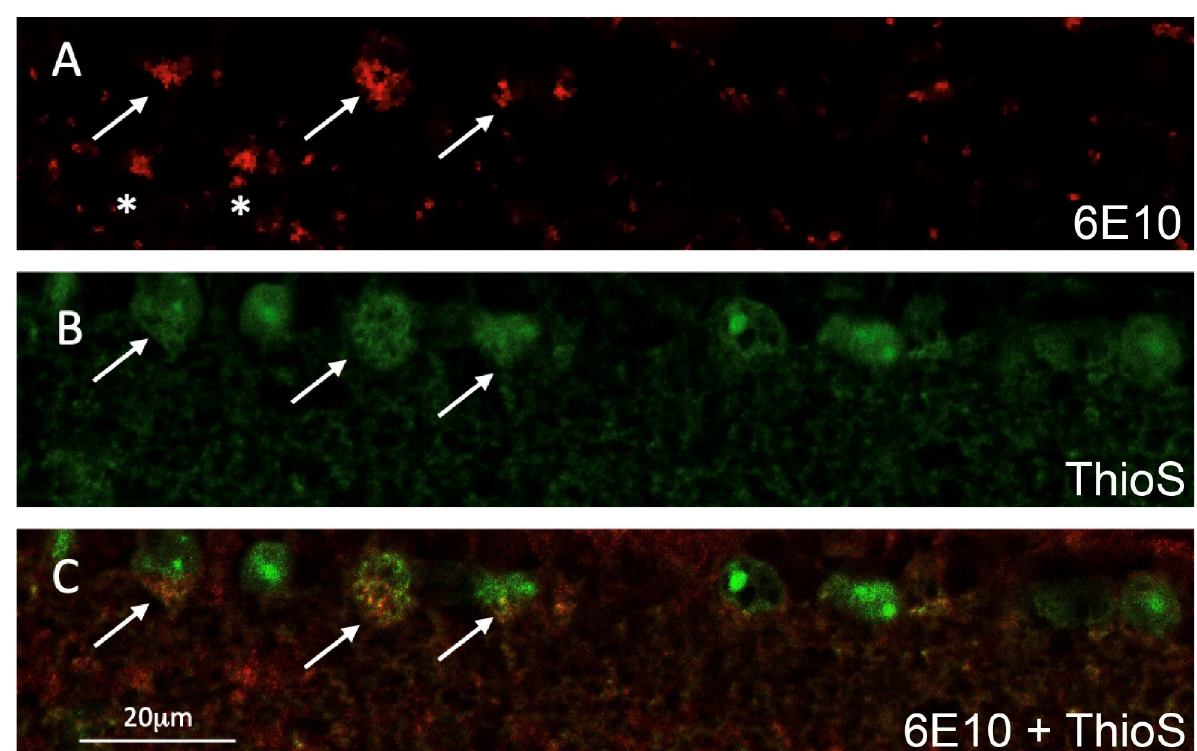
Figure 4. Representative confocal fluorescence imaging of a double-labeled retinal cross-section of a 5XFAD mouse after ThioS inhalation; ( A ) Abeta immunoreactivity (red, 546 nm channel) in retinal ganglion cells (RGC) shown by arrows and extracellular Abeta deposits shown by asterisks; ( B ) ThioS is seen in several RGCs (green, 488nm channel). Arrows indicate those ThioS labeled RGCs also immunolabeled for Abeta; ( C ) merged images of A and B showing double-labeled RGCs (arrows,